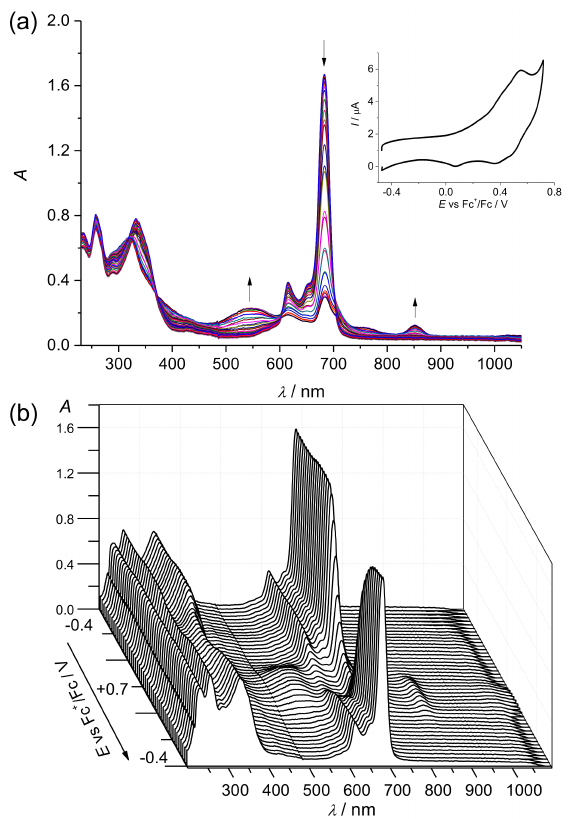
Figure 6. Evolution of UV-vis-NIR spectra in ( a ) 2D and ( b ) 3D projection upon cyclic voltammetry (see inset in ( a )) in the region of the first oxidation double-peak for complex 9 (Ni − Zr) in ACN/ n - Bu 4 NPF 6 at scan rate v = 10 mV s − 1